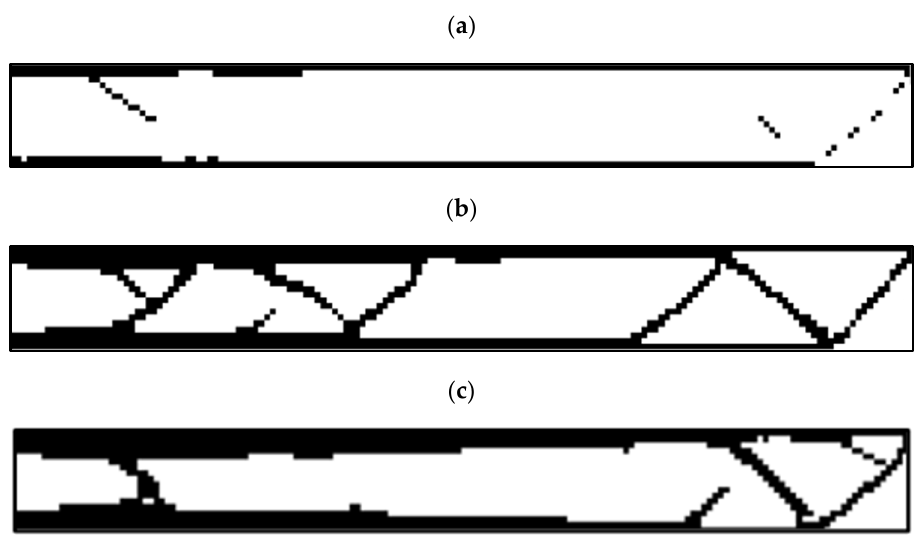
Figure 11. The results for the optimization of the rectangular plane in terms of ( a ) 20%, ( b ) 40%, and ( c ) 60% for the weight constraint.